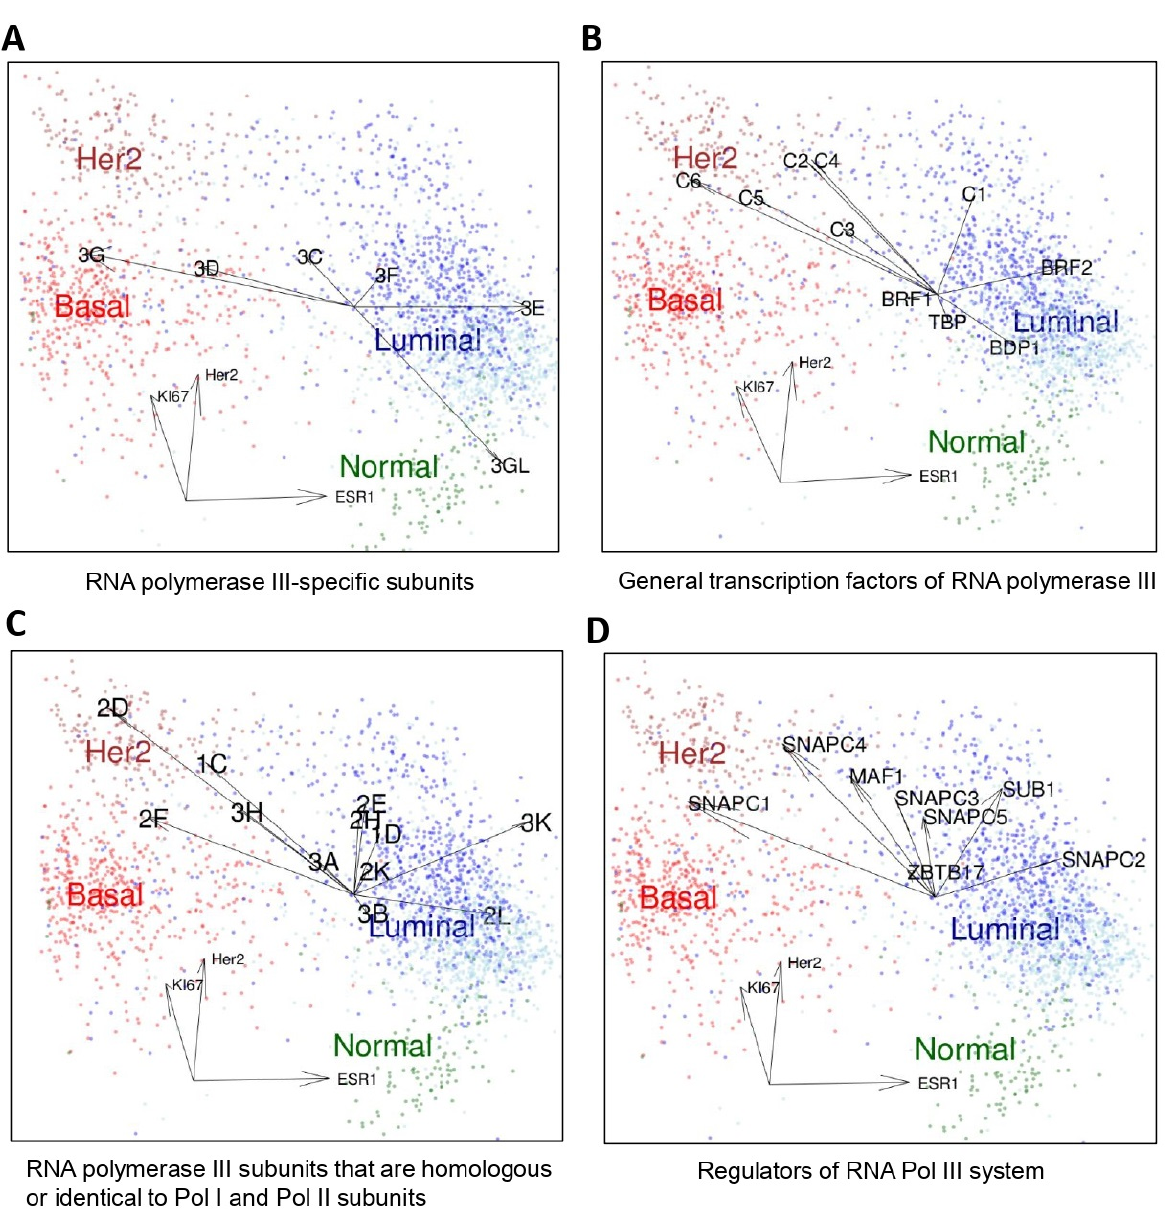
Figure 2. Three-dimensional scatterplot representations of the expression of Pol III subunits, transcription factors and regulators. The same 2627 samples shown in Figure 1 are presented according to the expression of HER2 (ERBB2), KI67 and ESR1 (estrogen receptor). A color code permits identification of individual tumor types and normal control: basal (red), Her2 (Brown), luminal A (dark blue) and luminal B breast cancers (light blue) as well as normal tissue samples (green). Correlations of the expression of Pol III transcription system components (polymerase subunits, general transcription factors, regulators) with these three axes are indicated by arrows. ( A ) RNA polymerase III-specific subunits. POLR3G expression correlates with the basal group and POLR3GL expression with normal tissue. The following abbreviations are used: 3G, POLR3G; 3D, POLR3D, 3C, POLR3C, 3F, POLR3F, 3E, POLR3E, 3GL, POLR3GL. ( B ) General RNA polymerase III transcription factors TFIIIC and TFIIIB. C1 to C6 correspond to GTFC1 to GTFC6 [reviewed in 6–8]. BRF1, BRF2, BDP1 and TBP constitute the two TFIIIB- α and TFIIB- β activities. ( C ) RNA polymerase (Pol) III subunits that are homologous or identical to Pol II or Pol I subunits (as in ( A ), “POLR” has been omitted before the gene symbols for the sake of simplicity). ( D ) Regulators of RNA polymerase III system. SNAPC1-5: subunits of PTF/SNAPC complex (6–8). SUB1 = PC4 [25]. ZBTB17 = MIZ1